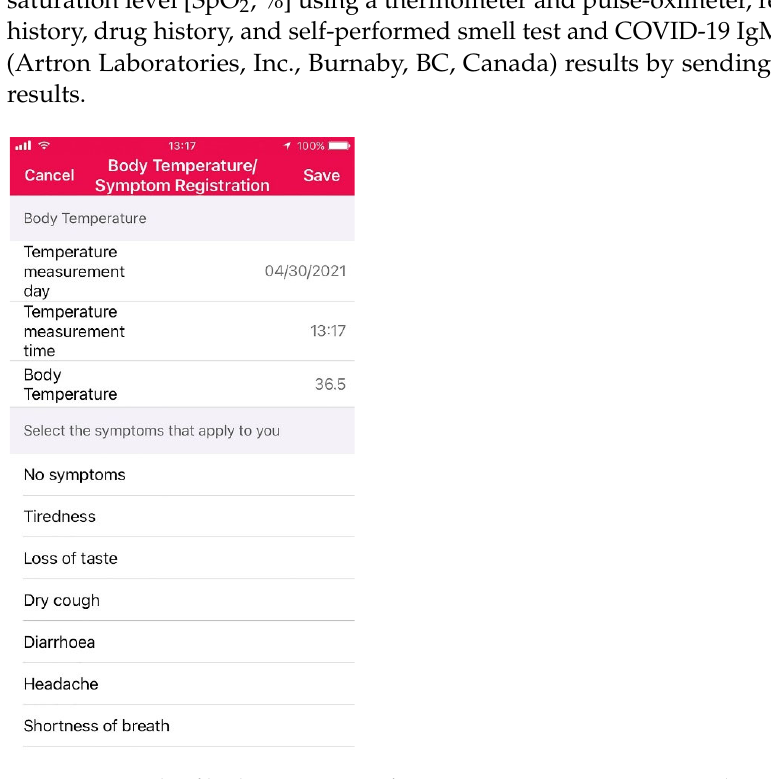
Figure 2. Sample of body temperature/symptoms. Users can register and manage their daily health condition and symptoms as screening items for COVID ‐ 19.